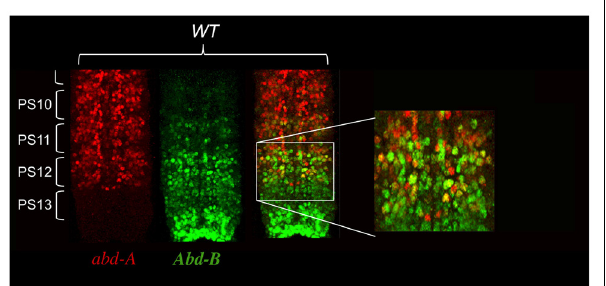
FIGURE 3 | abd-A and Abd-B are both co-expressed in some cells of the central nervous system. CNS of stage 15 embryos stained for abd-A (red) and Abd-B (green) were dissected and mounted on a slide with anterior on top. Parasegments boundaries are shown. Note the presence of neurons in PS10 to PS12 expressing both proteins as seen by the yellow color. Often the neurons expressing high level of abd-A also express Abd-B . (original observation published in Gummalla etal.,